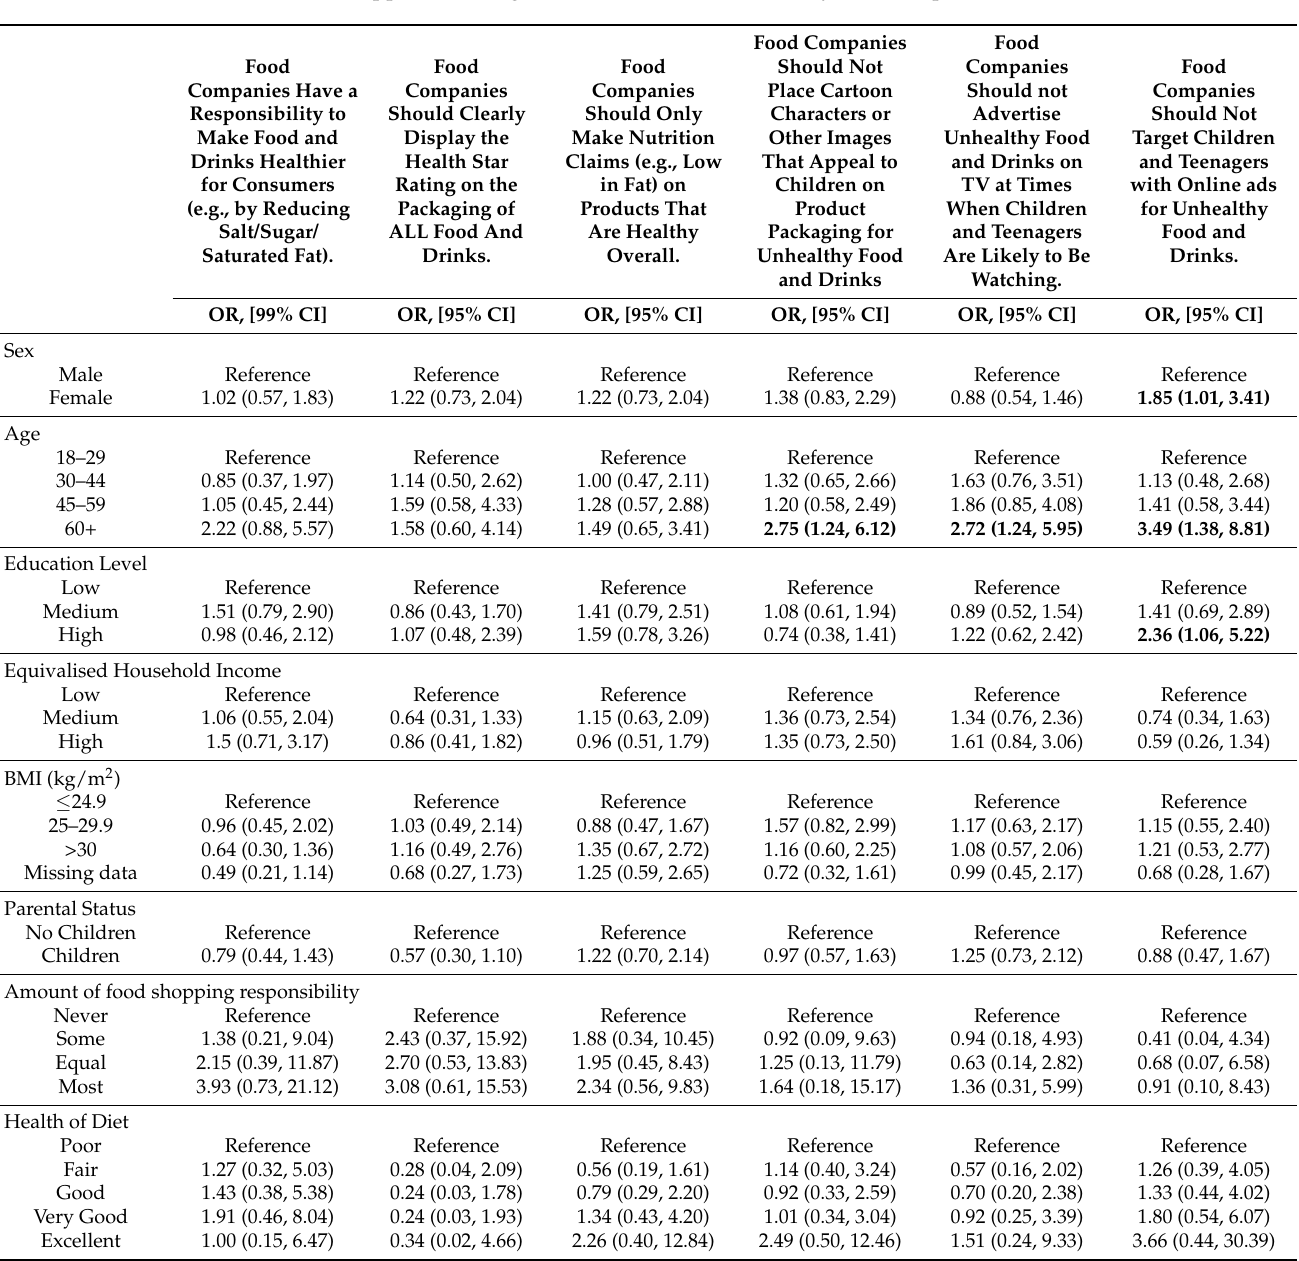
Table 3. Results * from the multivariable logistic regression model (OR, 99% Confidence Intervals **) for support of a range of nutrition-related actions by food companies, IFPS,